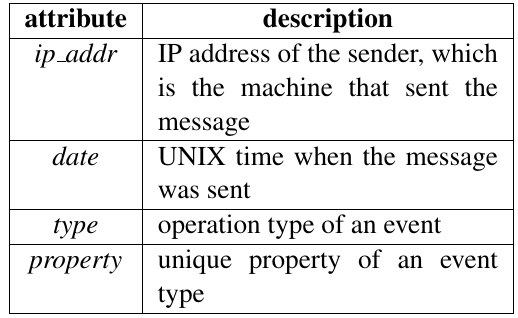
Table 3. The structure of the operational synchronous message attribute